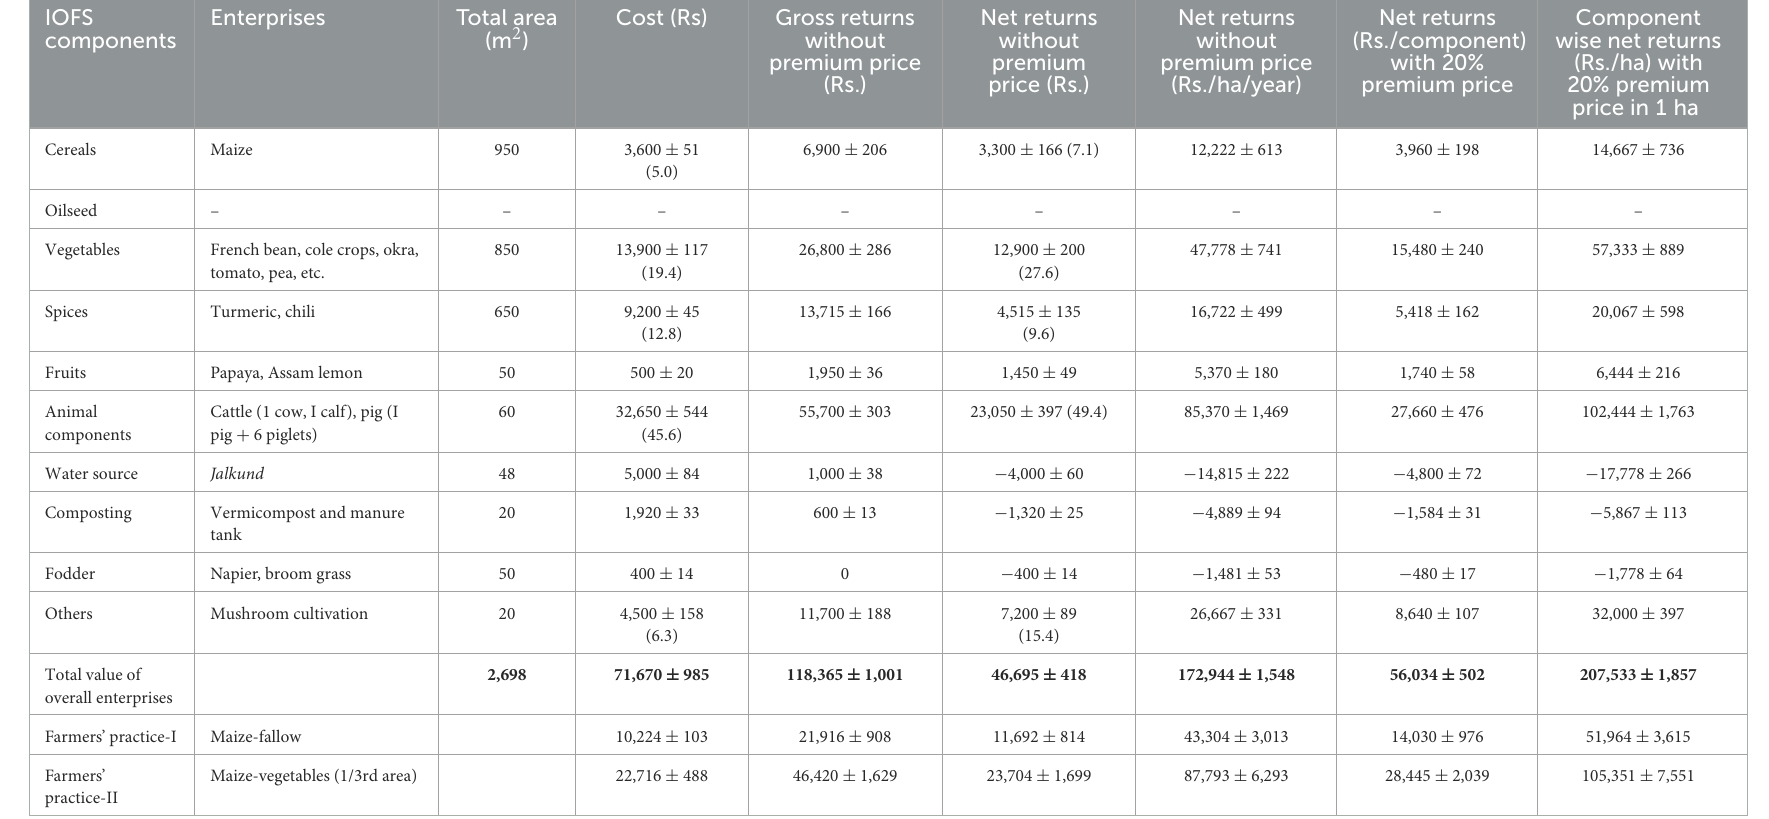
TABLE 3 Detailed analysis of the IOFS model developed at Mr. Jril Makroh’s farm (average of 5 years). IOFS